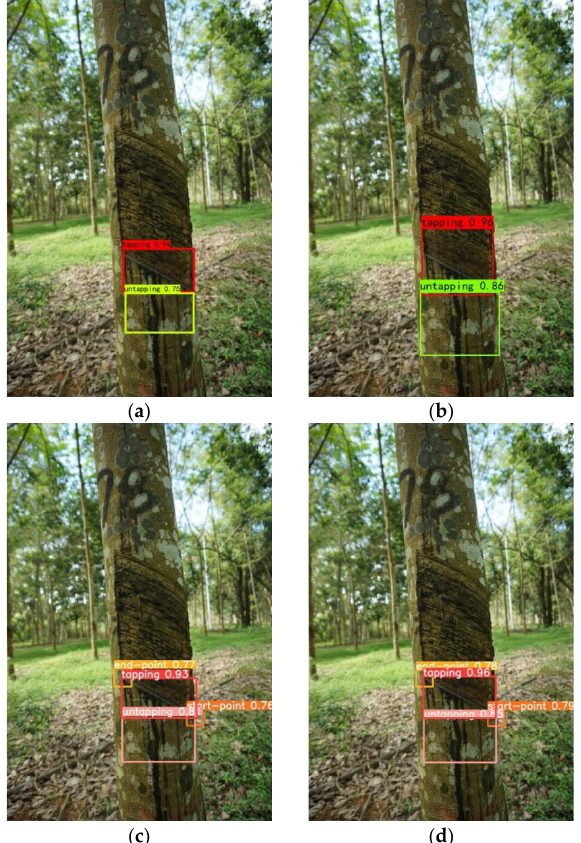
Figure 10. Detection results of four models. ( a ) Image predicted by SSD, ( b ) Image predicted by YOLOv3, ( c ) Image predicted by YOLOv5, ( d ) Image predicted by YOLOv5-CCE.